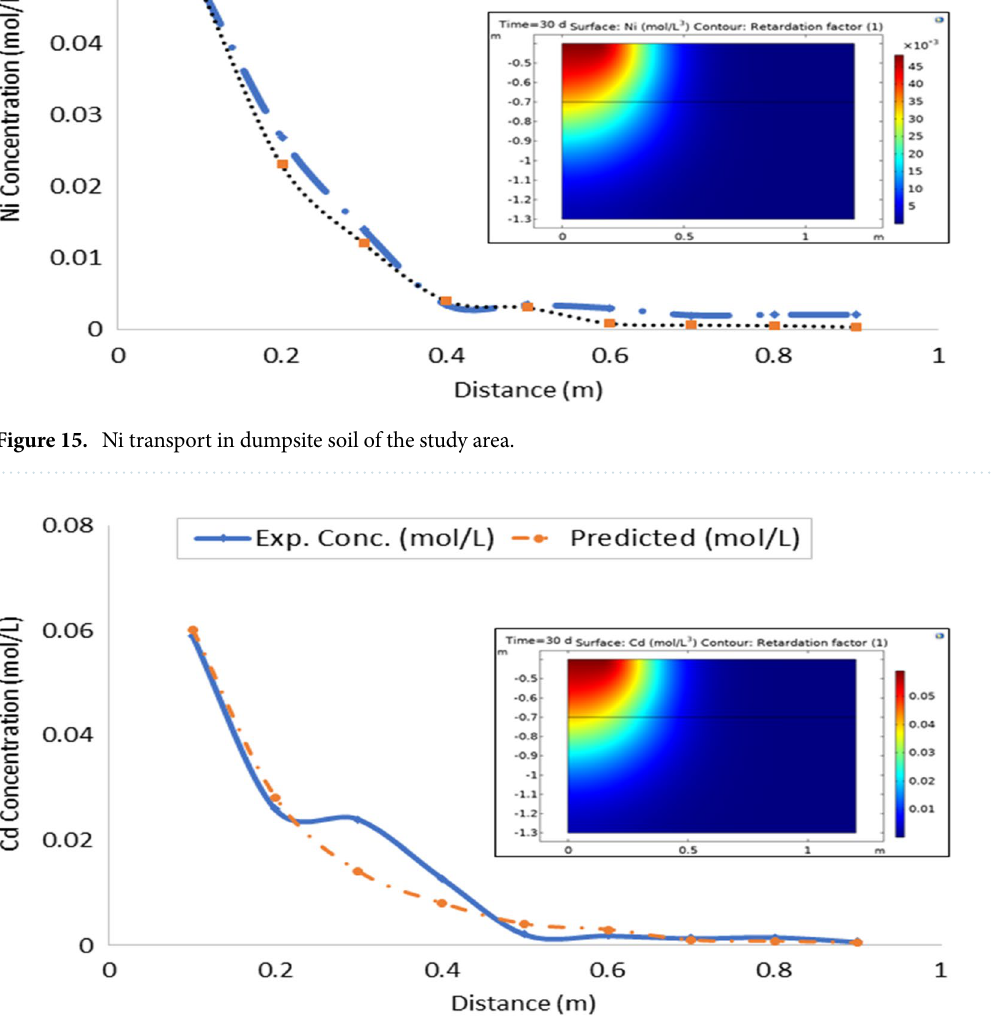
Figure 16. Cd transport in dumpsite soil of the study area.